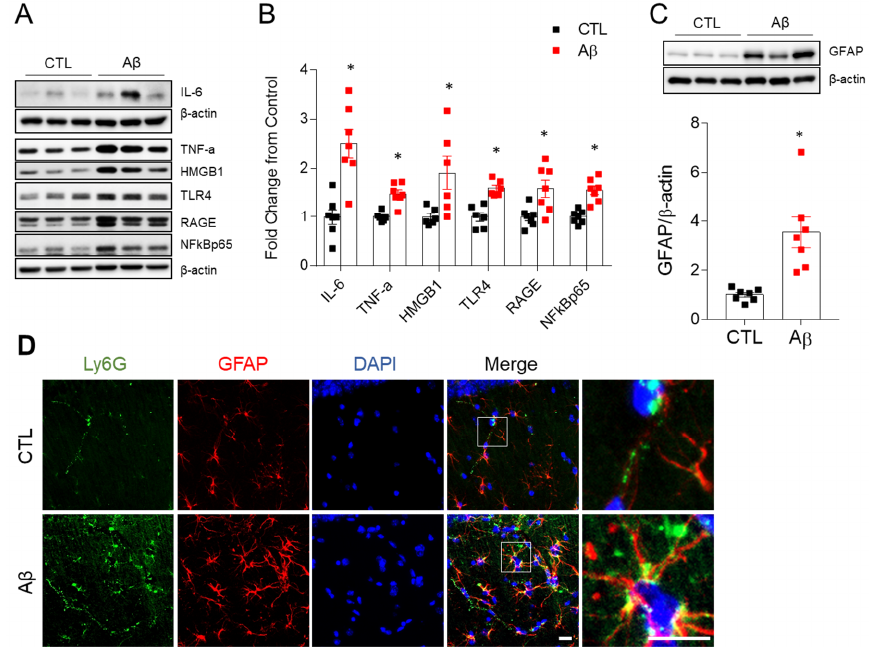
Figure 3. Effects of AβO toxicity on neuroinflammation in the hippocampus. ( A ) Western blot analysis of IL-6, TNF-α, HMGB1, TLR4, RAGE, and NF-κBp65 in the hippocampus. ( B ) Quantitation of Western blot analysis in ( A ). To normalize total protein level, β-actin was used as a loading control. ( C ) Western blot and quantified hippocampal GFAP expression. To normalize total protein level, β-actin was used. The data are presented as mean ± SEM. * p < 0.05 for control compared with Aβ-treated mice. ( D ) Representative immunofluorescence images (×200) of hippocampal CA1 regions showing Ly6G (green) and GFAP (red) staining. DAPI (blue) was used to stain nuclei. Scale bar = 10 µm.